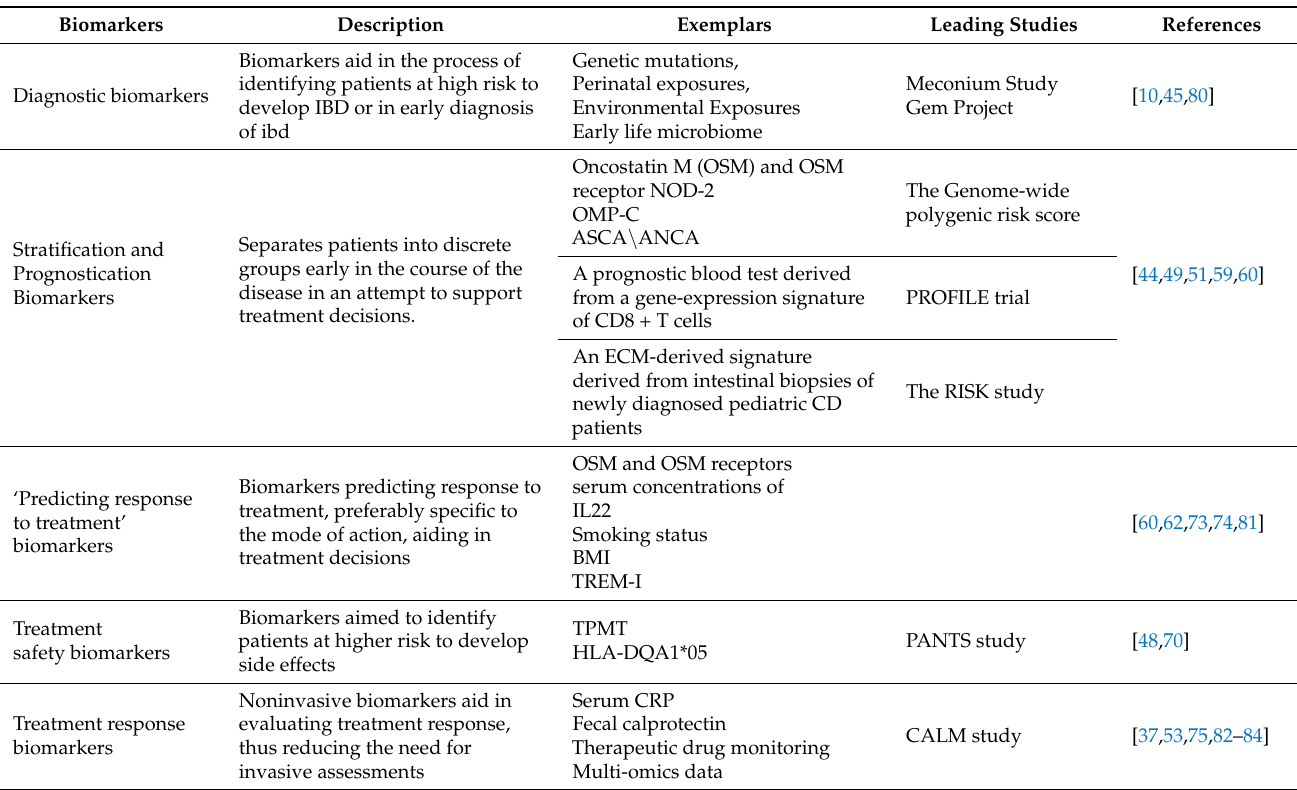
Table 2. The present and future potential biomarkers integrated into IBD practice, categorized by the specific intent of the